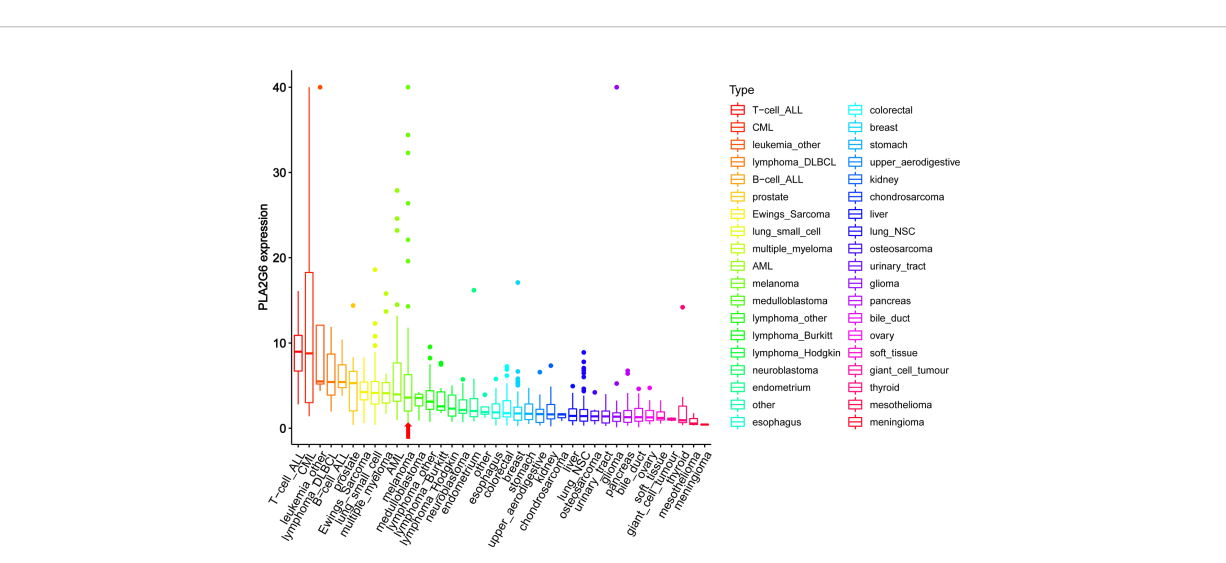
FIGURE 2 | The mRNA levels of PLA2G6 in various cancer cell lines were obtained at Cancer Cell Line Encyclopedia (CCLE). The red arrow showed the mRNA levels of PLA2G6 in